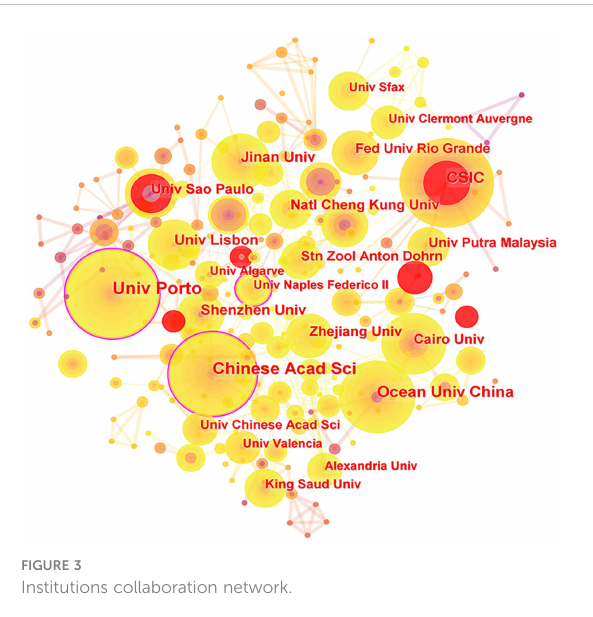
FIGURE 3 Institutions collaboration network.